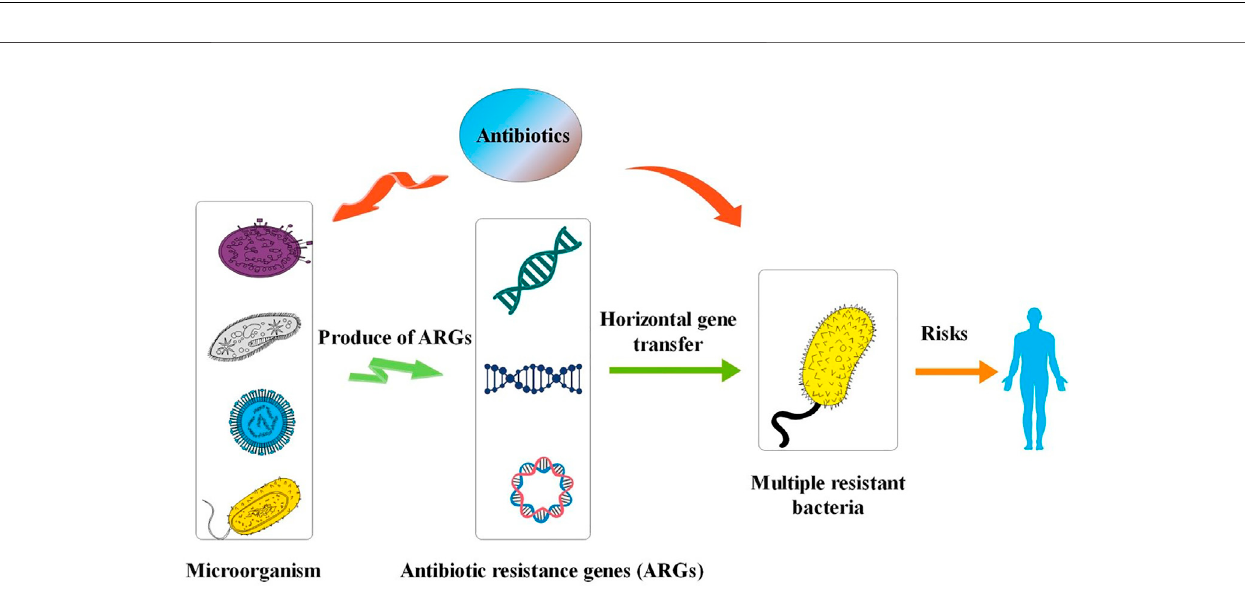
FIGURE 4 | Antibiotic resistance genes induced by antibiotics and horizontal gene transfer.